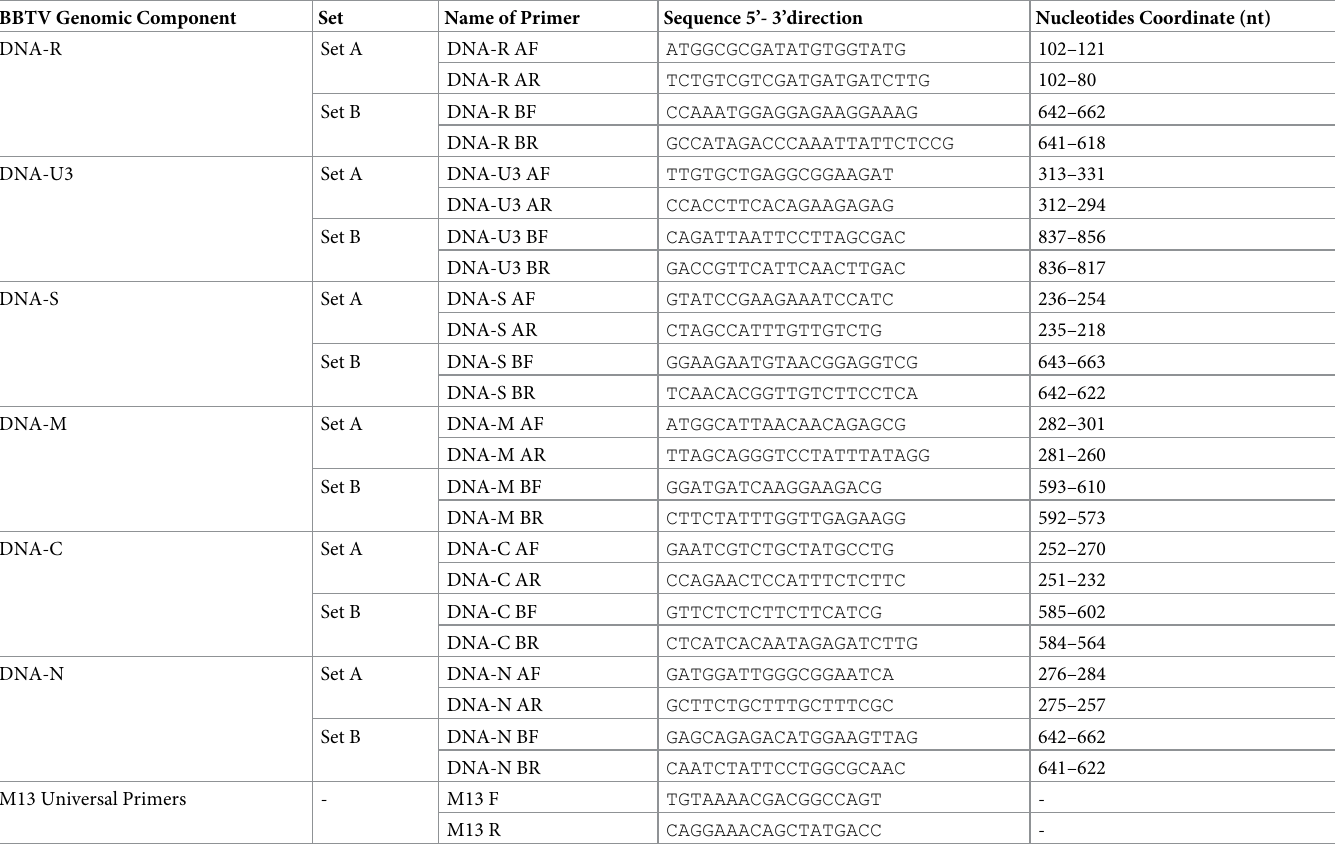
Table 1. Details of primers used to sequence BBTV genomic components from